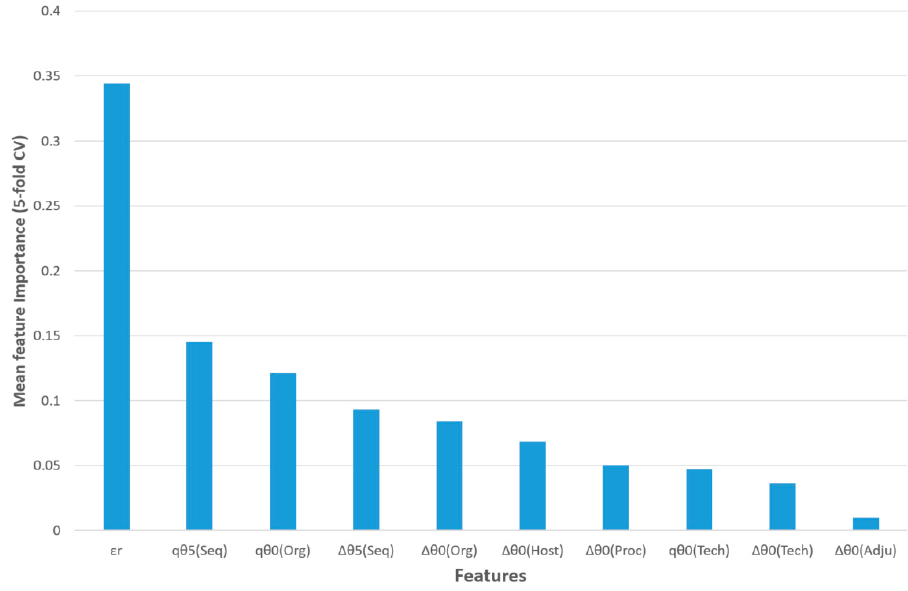
Figure 3. Feature importance for the best RF classifier.